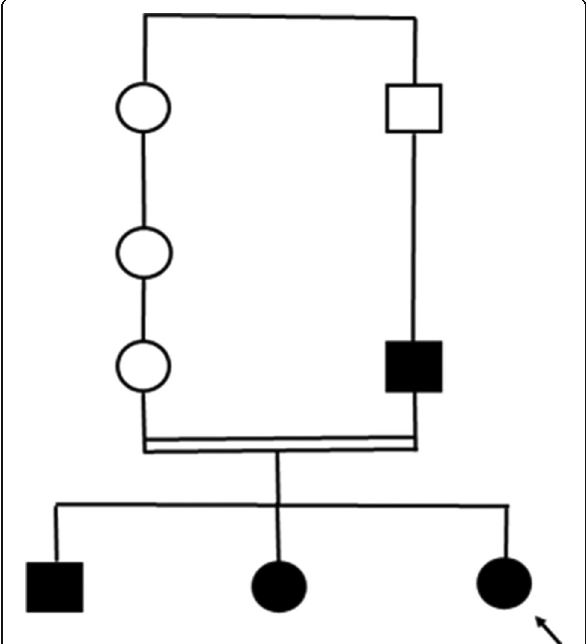
Fig. 1 Pedigree of the family. The arrow indicates patient 1 which is the